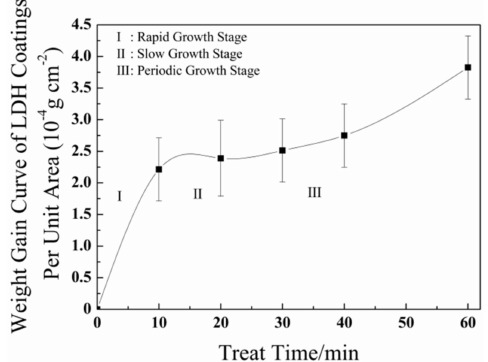
Figure 5. Weighted gain curves of the LDHs coatings at different formation